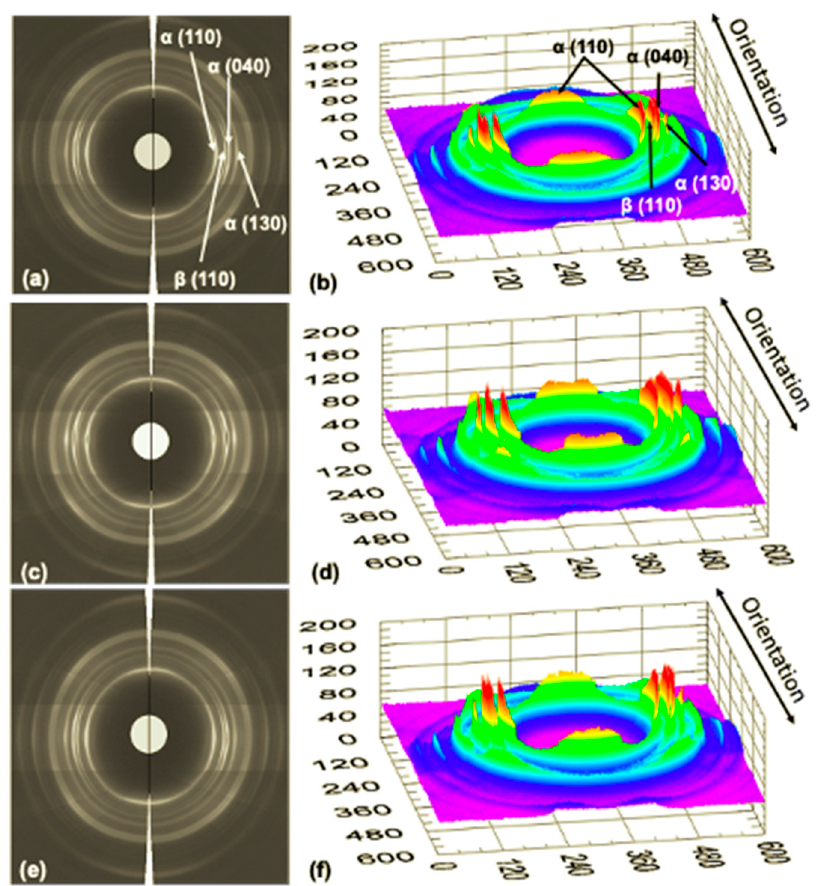
Figure 6. 2D and 3D WAXS patterns of the iPP probes injected at constant ultrasound time (6 s) and different amplitudes: ( a , b ) 80%, ( c , d ) 90%, and ( e , f ) 100%. The primary crystalline reflections of the α crystalline phase: (110), (040), and (130), and β crystalline phase (110) of iPP are also shown.